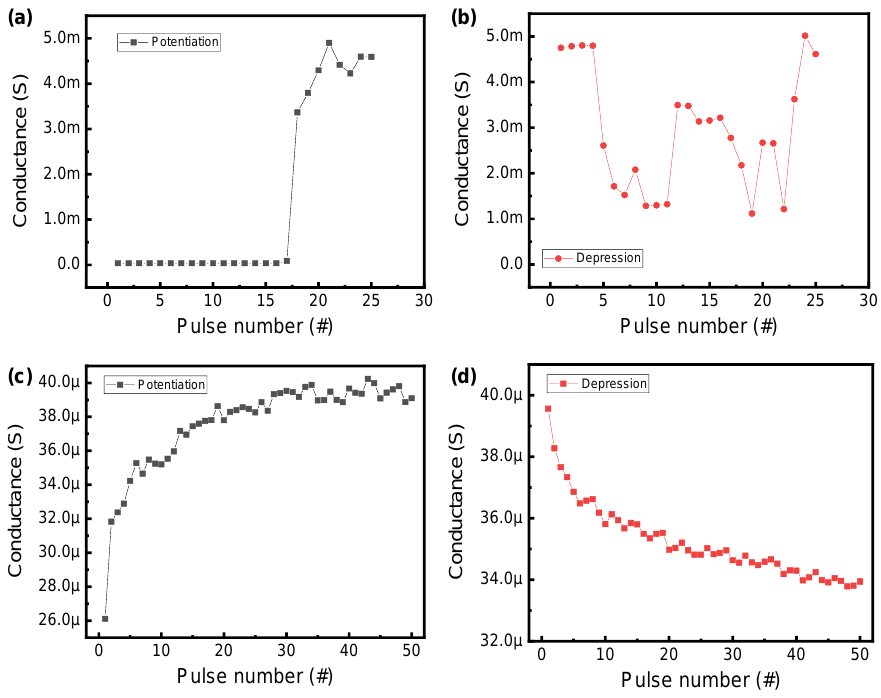
Figure 5. Potentiation and depression characteristics for ( a , b ) Ni / HfO 2 / SiO 2 / Si device and ( c , d ) Ni / HfO 2 / Si 3 N 4 / SiO 2 / Si device.